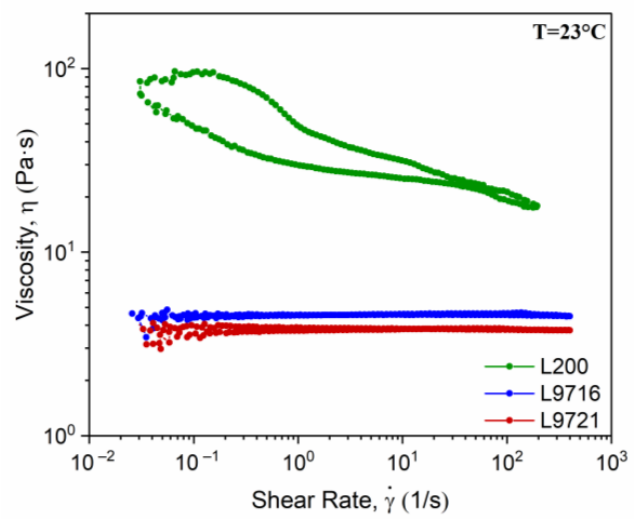
Figure 1. Flow characteristics of the binders used for the preparation of TISS paints.